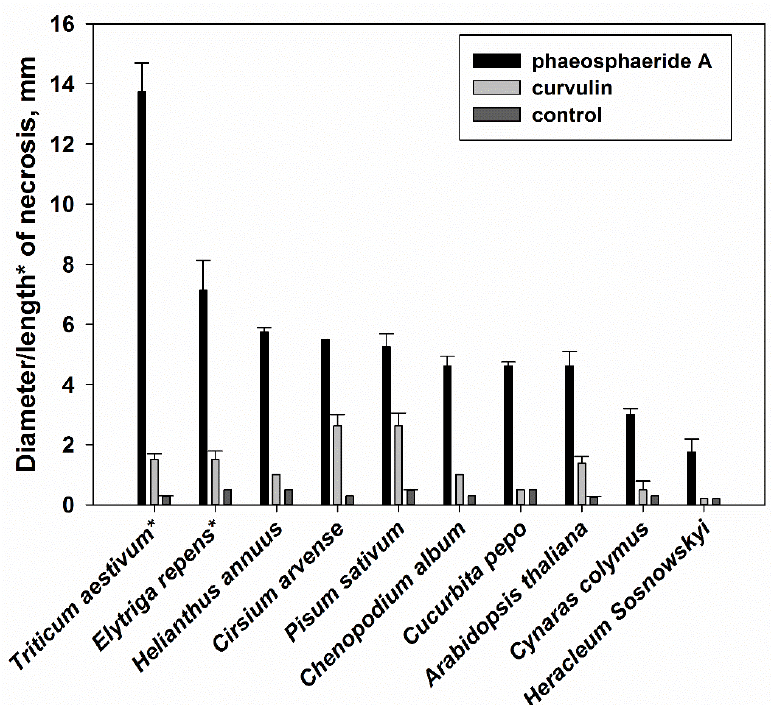
Figure 3. Phytotoxic selectivity of curvulin and phaeosphaeride A. tested at 840 μM and 335 μM, respectively (10 μL/leaf disc/leaf segment). Bars indicate standard deviation at p = 0.05. The length of necrosis was measured when leaf segments of T. aestivum and E. repens were used, while for other plant species the diameter of the necrosis was estimated.